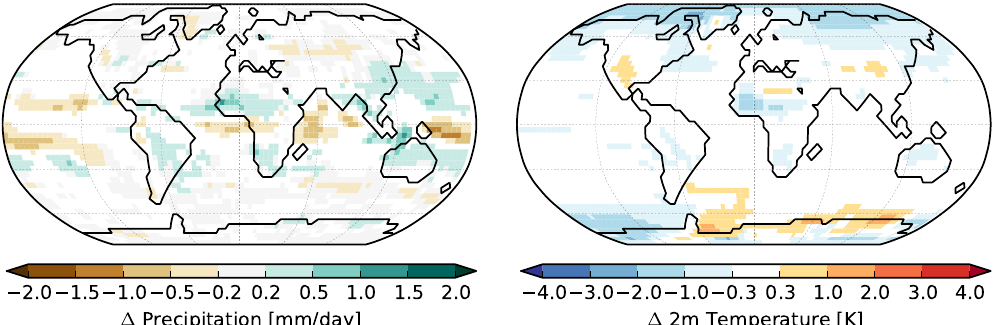
Figure 11. Differences in precipitation and 2m temperature between the end of the FD P simulation and the end of the DD P simulation. Depicted differences are significant on a 95% level.